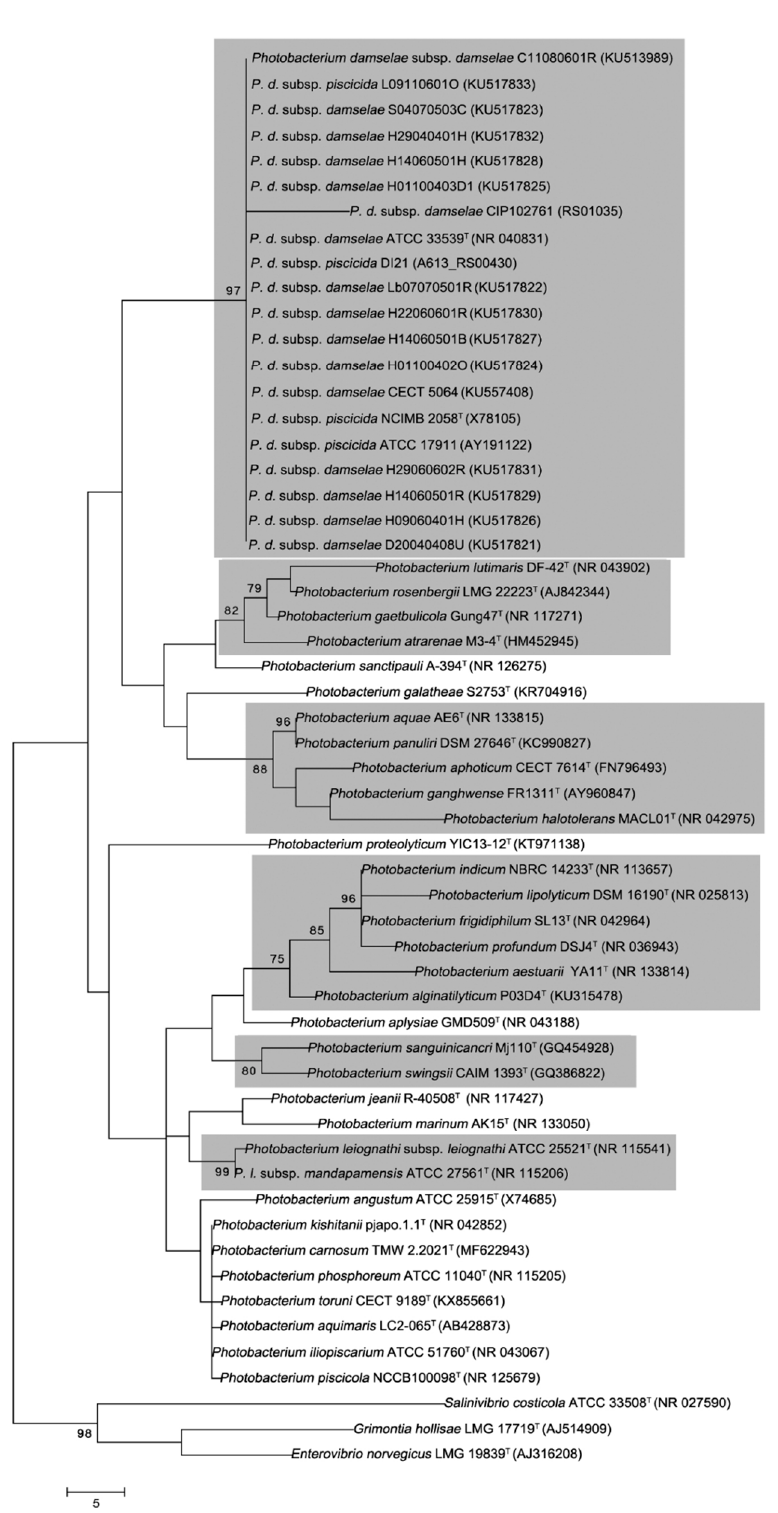
Figure 1. Maximum Parsimony phylogenetic tree based on 16S rRNA gene sequences of environmental and type strains of Photobacterium species. Grimontia hollisae , Enterovibrio norvegicus and Salinivibrio costicola type strain sequences have been added as outgroup. Sequence accession numbers are given in parentheses. Bootstrap values greater than 75% confidences are shown at branching points (percentage of 1000 resamplings). Bar indicates number of substitutions per position. Shaded gray delimited the clades defined.